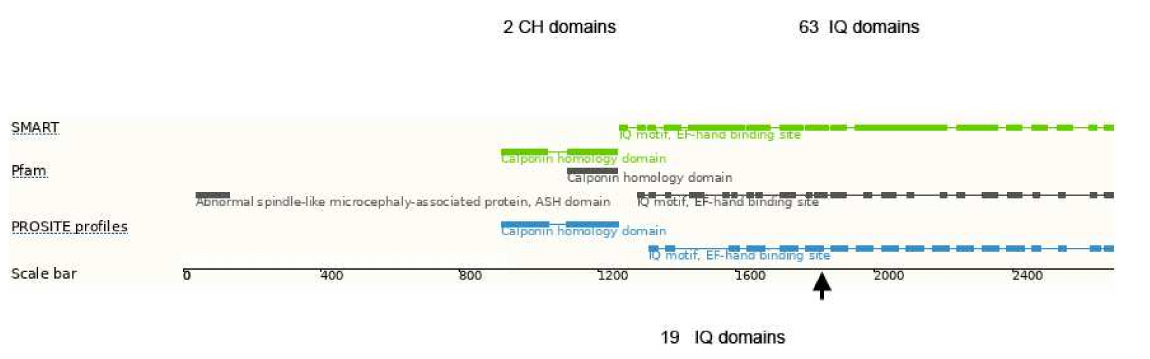
Figure 3. Domain structure of the human ASPM protein. CH domains–calponin homology domains, IQ domains–isoleucine-glutamine domains. The arrow indicates the truncation position due to the homozygous p .Ile1826Serfs*4 mutation, leaving 19 intact IQ domains. Modified according to